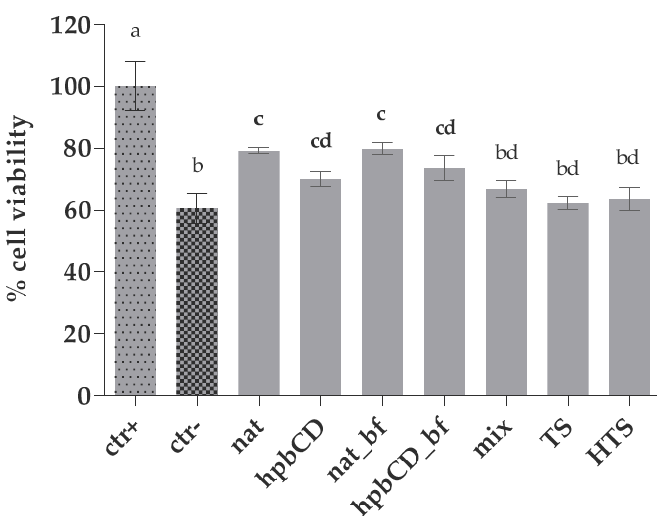
Figure 1. Protective effect of OPEs and pure polyphenols against oxidative stress on HepG2 viability. Data are presented as mean ± standard deviation ( n = 3) of the percentage calculated according to Equation (1); Positive control cells (ctr+) were treated with PBS while negative control cells (ctr − ) were treated with tBOOH. All the other cells were treated both with samples and tBOOH. The final concentrations of the samples in wells are noted in Table 1. Different letters (a, b, c, d) indicate statistically significant differences compared to ctr+ ( p < 0.05). Native olive pomace extract (nat), olive pomace extract with hydroxypropyl β -cyclodextrin (hpbCD); bioaccessible fraction (bf), tyrosol (TS), hydroxytyrosol (HTS), TS and HTS in the same concentration as in native sample (mix).